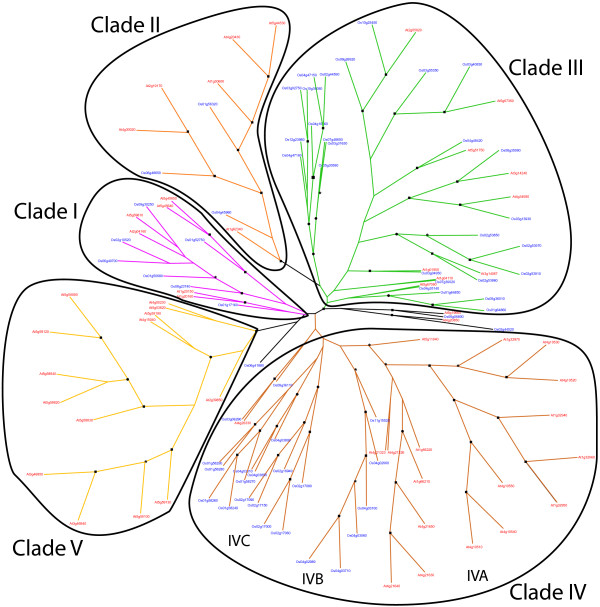
Unrooted N-J tree computed from multiple sequence alignments of Arabidopsis (red) and rice (blue) subtilisin domains. Subtilisin-like protease domains were aligned using ClustalW [95] program and the alignments were exported to Phylip package [96] for representing the Neighbor-Joining tree (see methods). The colors and circles represent different evolutionary clades identified in the analysis (see text for details). Clade I is represented in purple, Clade II is shaded orange, Clade III in green, Clade IV in brown and Clade V in yellow. For clarity, bootstrap values were replaced with symbols representing bootstrap percentages >50%. Bootstrap values between 50–60% are represented by an asterix, circles represent bootstrap values from 60%–80% while bootstrap values >80% are represented by rectangles. Gene names correspond to those in Additional files 1 and 2. For brevity, rice gene names have been shortened to OsXXg##### instead of LOC_OsXXg#####, XX referring to chromosome 1–12 and a 5 digit number assigned to each gene. A few species specific gene clusters were also identified in the analysis (see text for details).